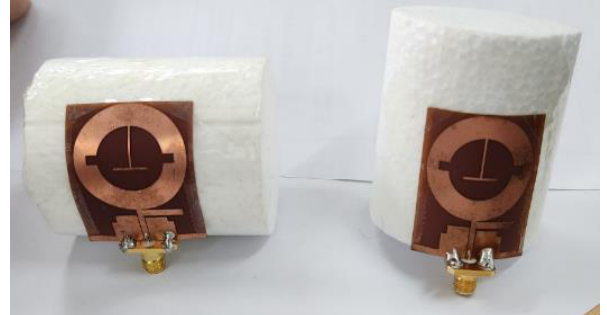
Figure 16. Photo of the antenna bent using a styrofoam cylinder.